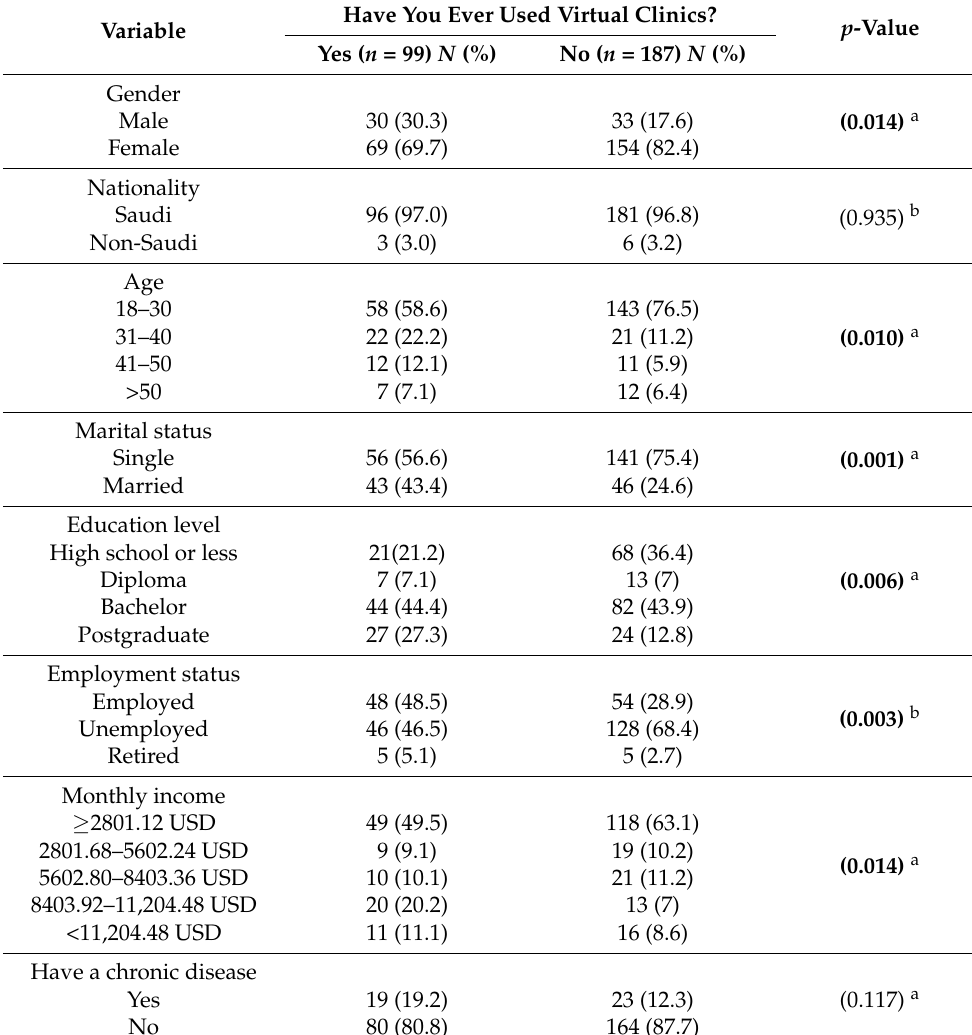
Table 3. Sociodemographic factors affecting virtual clinics’